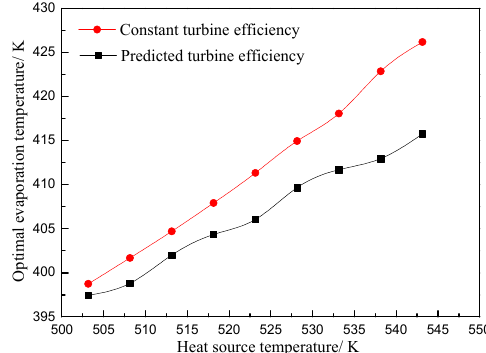
Figure 11. Optimal evaporation temperature at different heat source temperature.